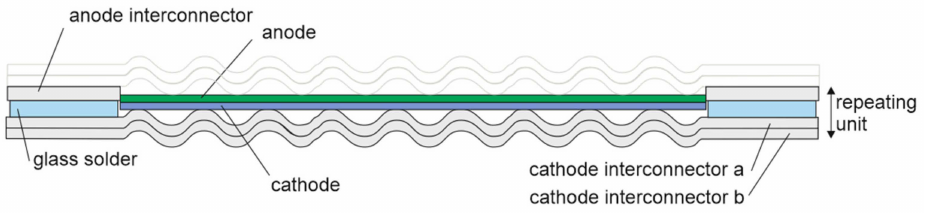
Figure 2. Left: Sketch of the structure of a cell element showing the glass solder seals (light blue) between the interconnectors (gray). At the top, the position of the next cell element in the stack is indicated.